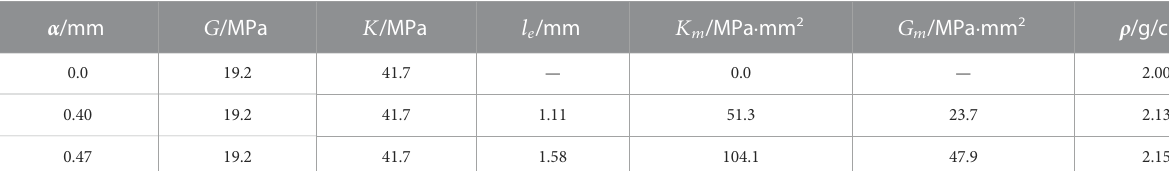
TABLE 4 Finite element method parameters of the proposed particle rotation